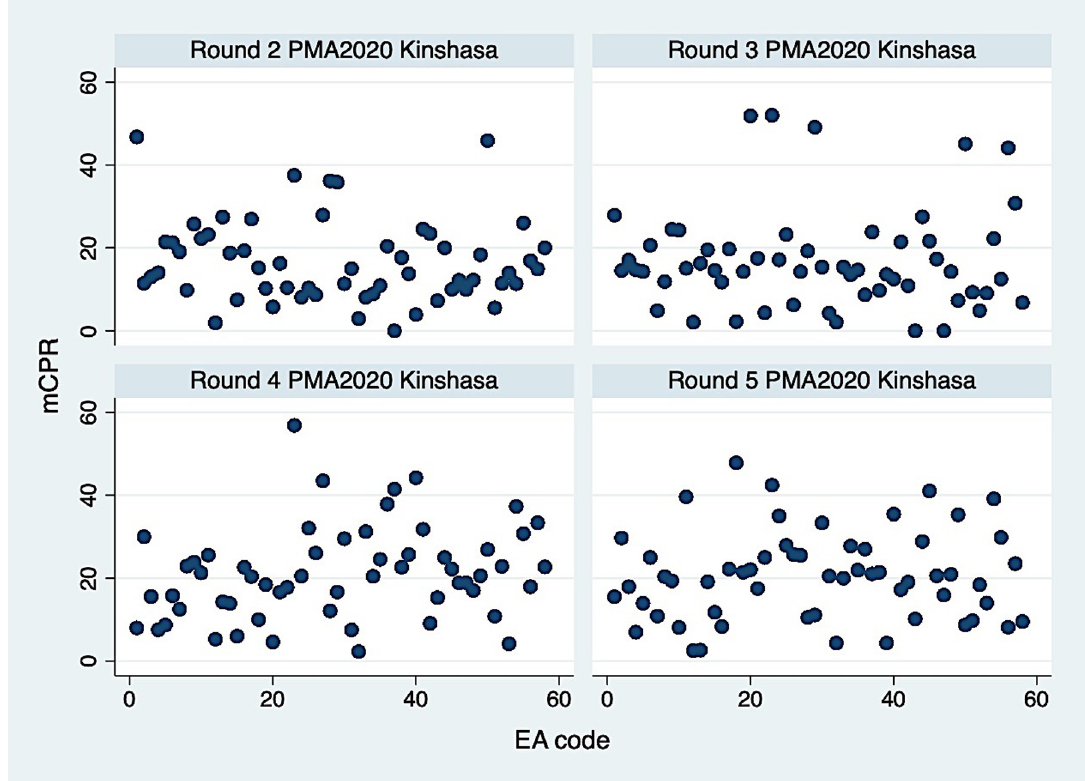
Fig 2. Modern contraceptive prevalence by EA in round 2–5 of PMA2020 Kinshasa, DR.